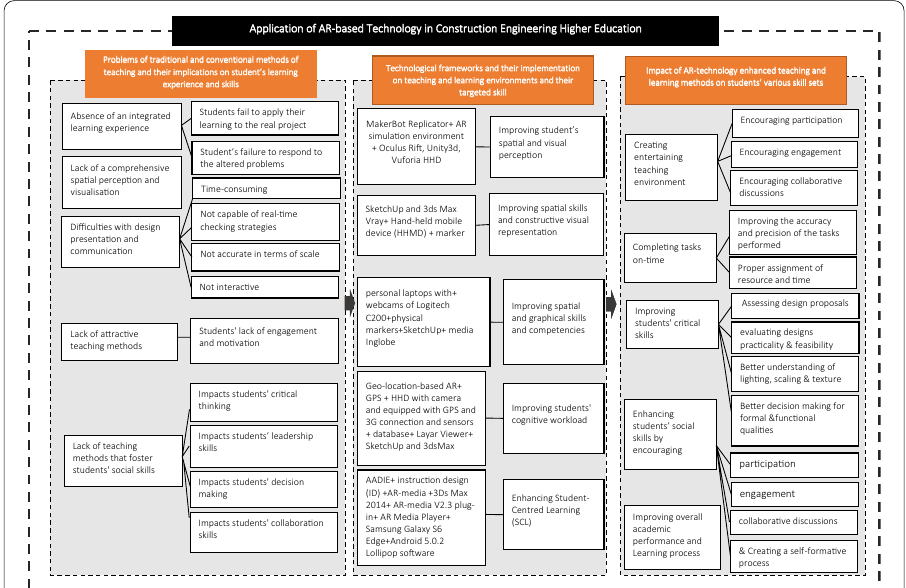
Fig. 8 The application of AR-based technology in architecture higher